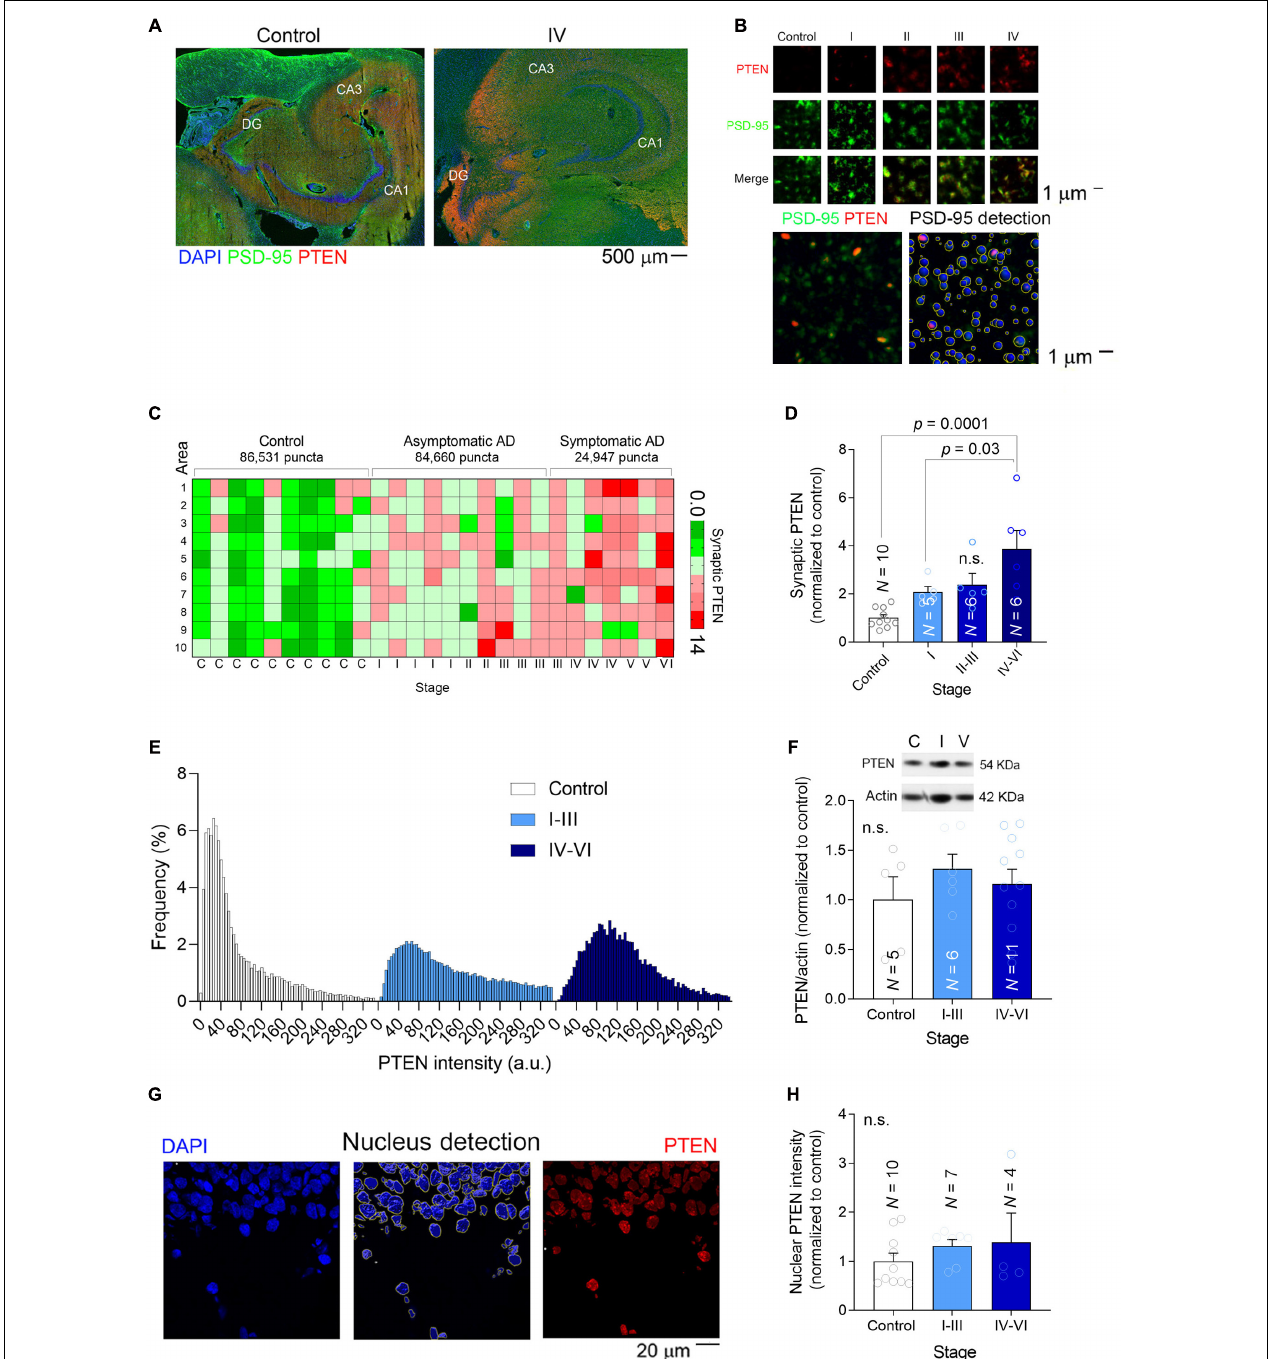
FIGURE 3 | Synaptic PTEN levels are enhanced in AD patients. (A) Tile-scanned confocal images ( × 10) of the hippocampal formation stained for PTEN (red) and PSD-95 (green): DG, Dentate Gyrus; CA1-3, Cornu Ammonis. (B) Top, High magnification super-resolution images (63 × ) showing PSD-95 puncta (green) and PTEN (red) at different stages. Bottom, Detection of PSD-95 puncta with Imaris software. (C) Heat map showing the average relative PTEN levels (normalized to controls) in 10 high-resolution confocal fields per patient. (D) A bar graph depicting the relative synaptic PTEN in each group of patients. N is the number of patients, and the P -values were determined by One Way ANOVA followed by Tukey’s multiple comparisons test. (E) Frequency distribution of the PTEN in individual PSD-95 puncta. (F) The total amount of PTEN in brain lysates was determined in western blots. Inset, a representative example of a blot at different stages. N is the number of patients and the P -values were determined by One Way ANOVA. (G) Left, A confocal image ( × 40) of part of the dentate gyrus showing the nuclei stained with DAPI. Middle, The detection of nuclei to determine the amount of nuclear PTEN. Right, The pixels outside the nuclear areas were set to zero to observe only nuclear PTEN (red). (H) A bar graph depicting the relative nuclear PTEN in each group of patients. N is the number of patients and the P -value was determined by One Way ANOVA.